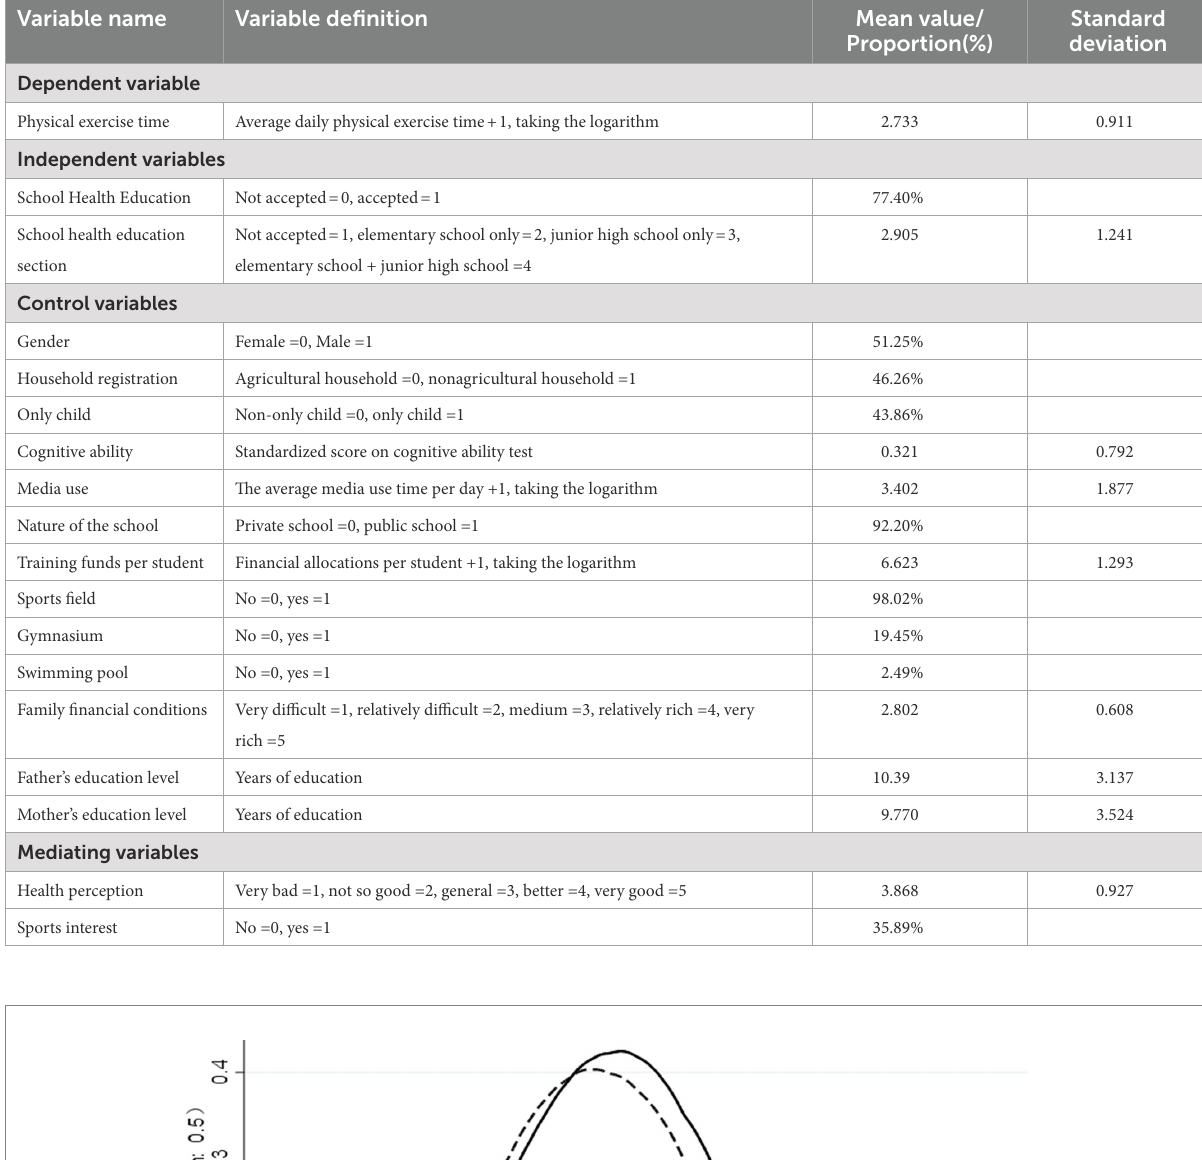
TABLE 1 Variable names, definitions, and descriptive